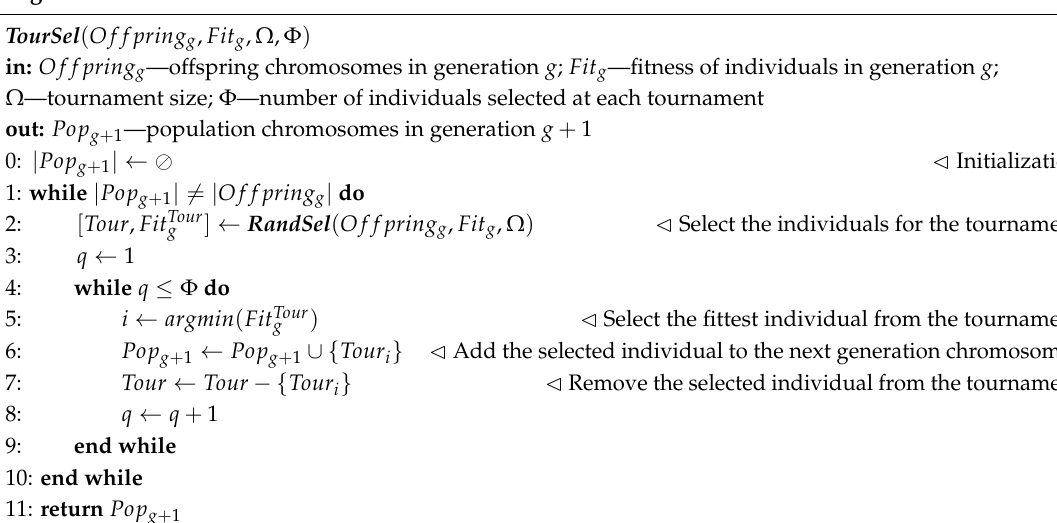
Algorithm 4: Tournament Selection. TourSel ( Of f pring g , Fit g , Ω , Φ